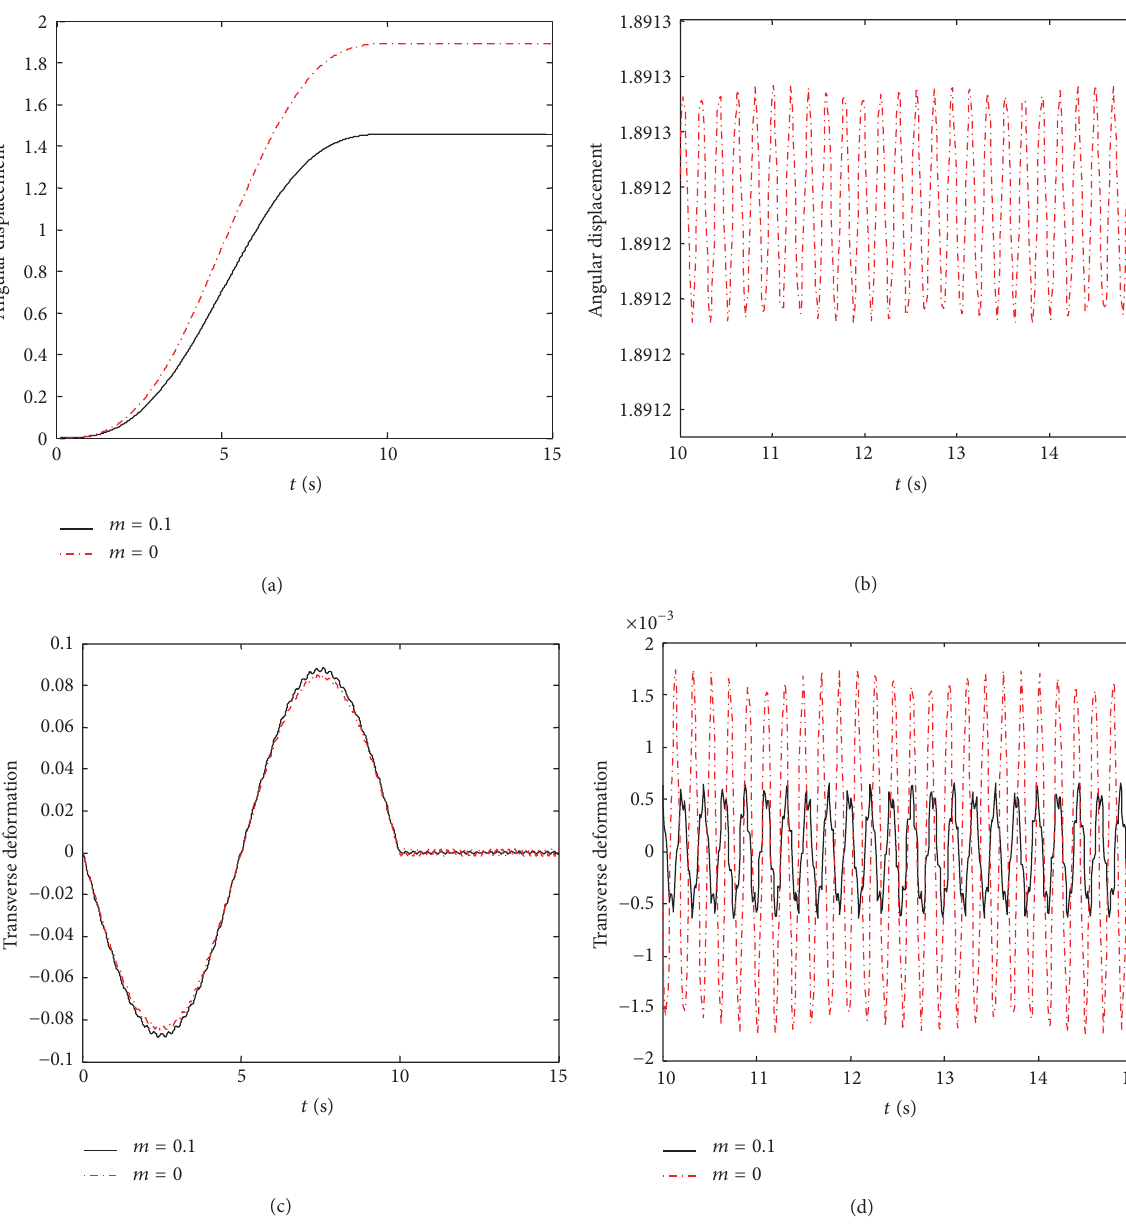
Figure 5: Effect of the concentrated mass on the angular displacement and transverse deformation when flexible beam is subjected to a sine function couple: (a) angular displacement, (b) local diagram of angular displacement, (c) transverse deformation, and (d) local diagram of transverse